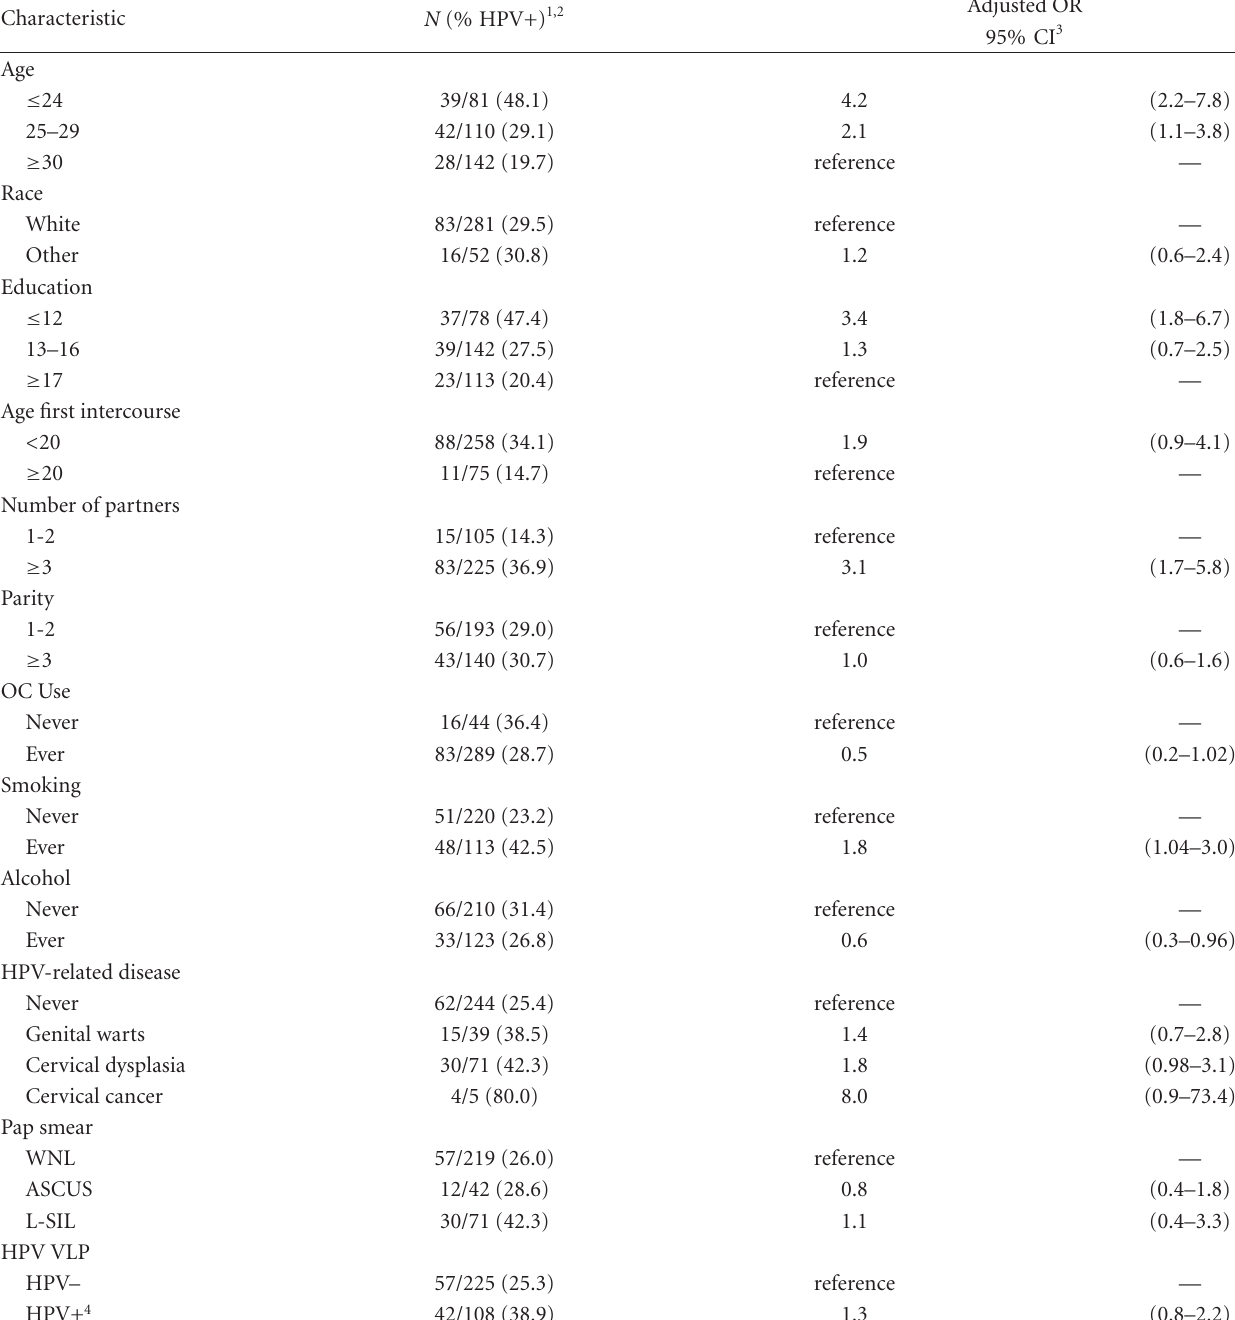
Table 1: Demographic characteristics and risk factors for HPV DNA positivity among mothers ( n =